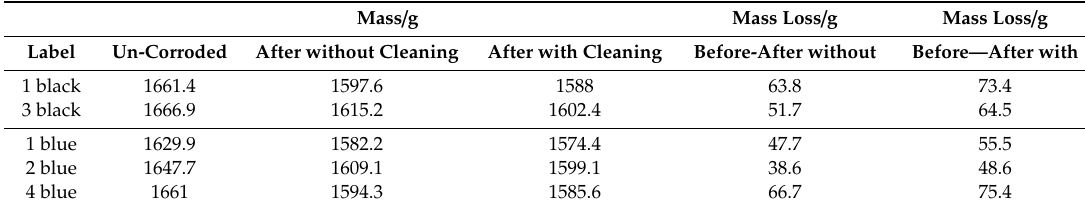
Table A1. Raw and processed data from mass